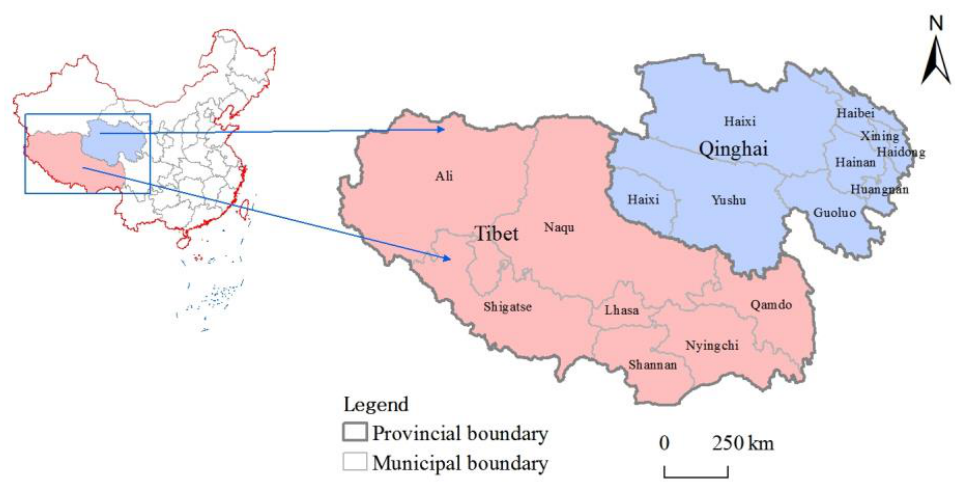
Figure 1. Overview map of the study area (source: GS(2019)1822).